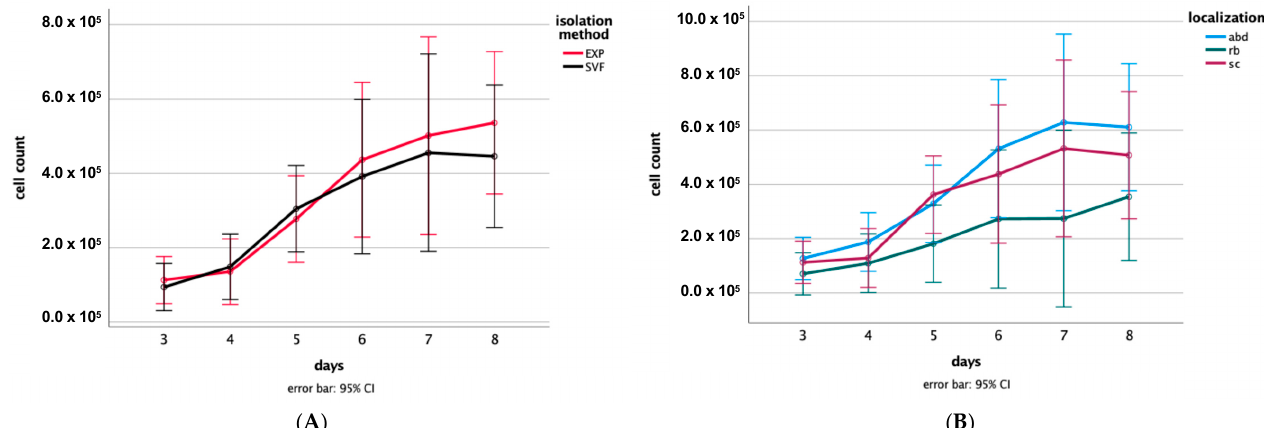
Figure 2. Cell growth curves of equine adipose-derived stem cells of passage 3. The proliferation ability of ASCs- SVF (black) und ASCs- EXP (red), which were isolated from abdominal (abd, blue), retrobulbar (rb, green) and subcutaneous (sc, dark red) adipose tissue of n = 3 horses, were determined on days 3 to 8. Cell counts are summarized for isolation techniques ( A ) and adipose tissue localizations ( B ).